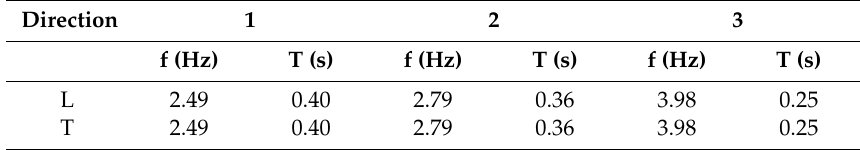
Table 1. The first three peaks in order of increasing frequencies, picked in the L and T directions.